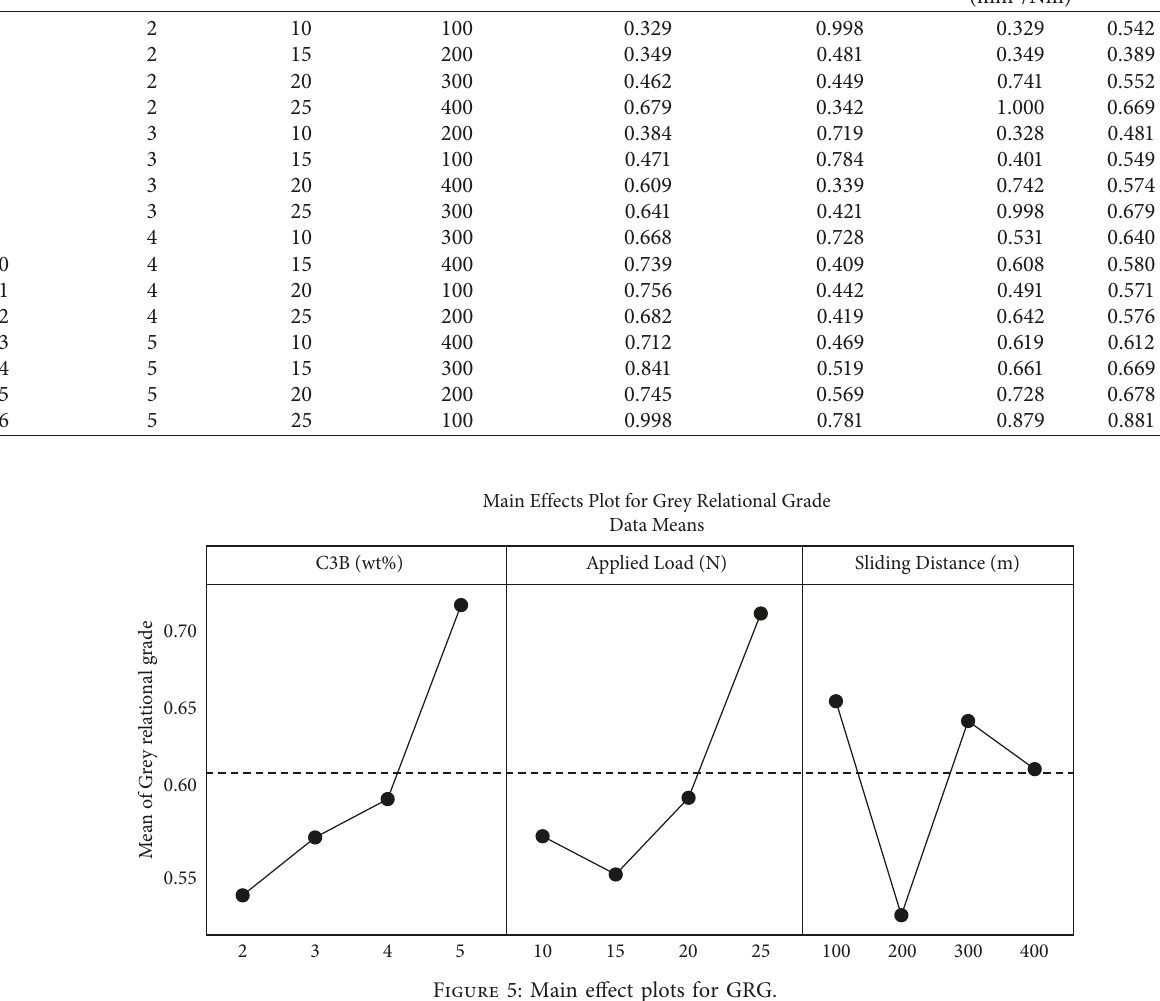
Figure 5: Main effect plots for GRG.